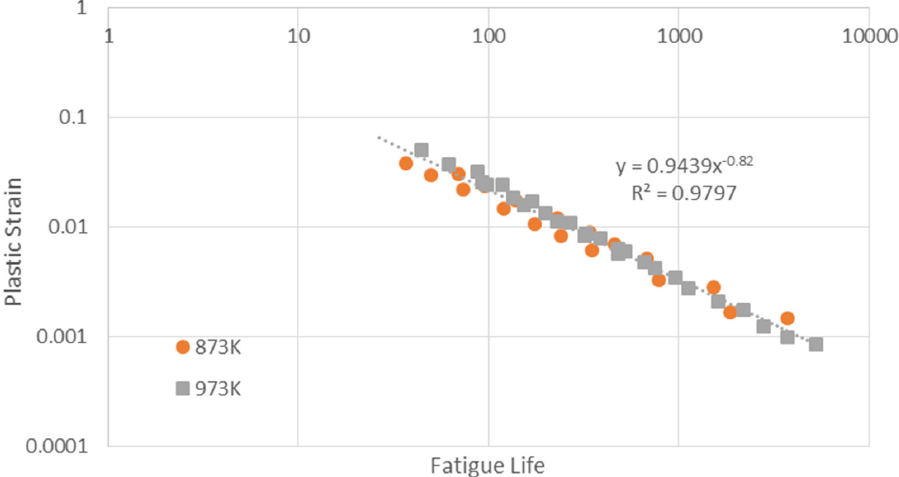
Figure 5. Transformed ε p, ref – N data (above 873 K) of stainless steel 316 using Equation (17) with functions c ( T , t ) and b ( T , t ).